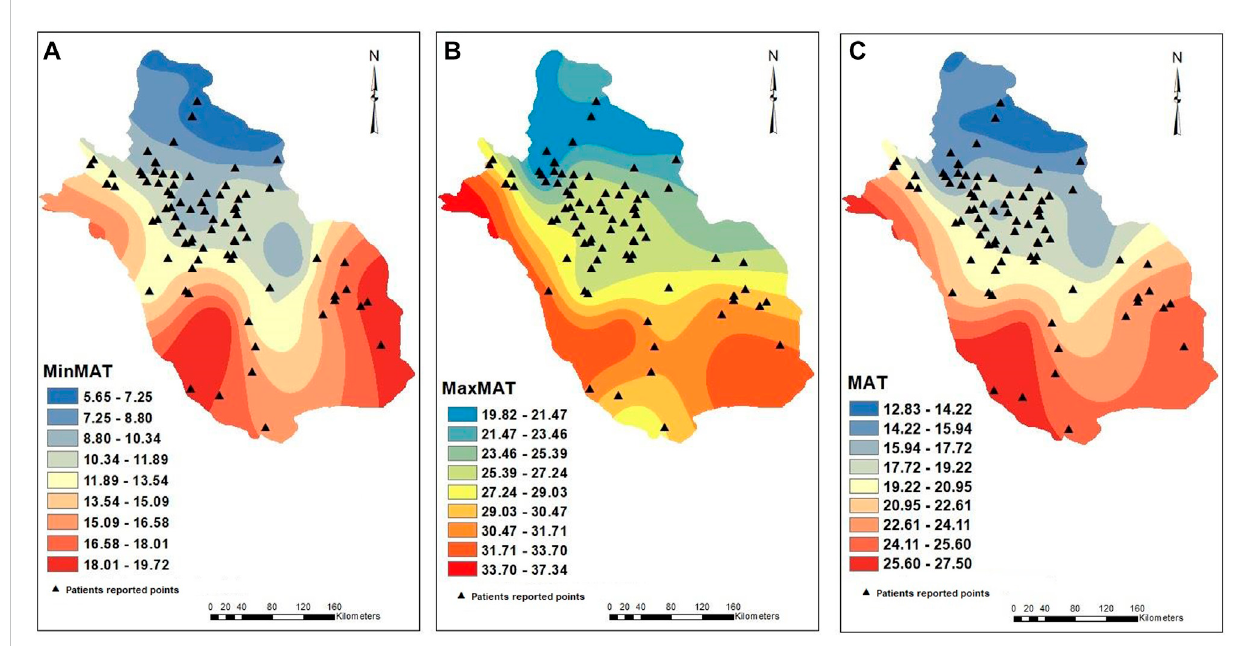
FIGURE 2 Isothermal raster models. Points with acute adult asthma (triangle symbol) located in areas with varied range of MinMAT (A) , MaxMAT (B) , and MAT (C) .